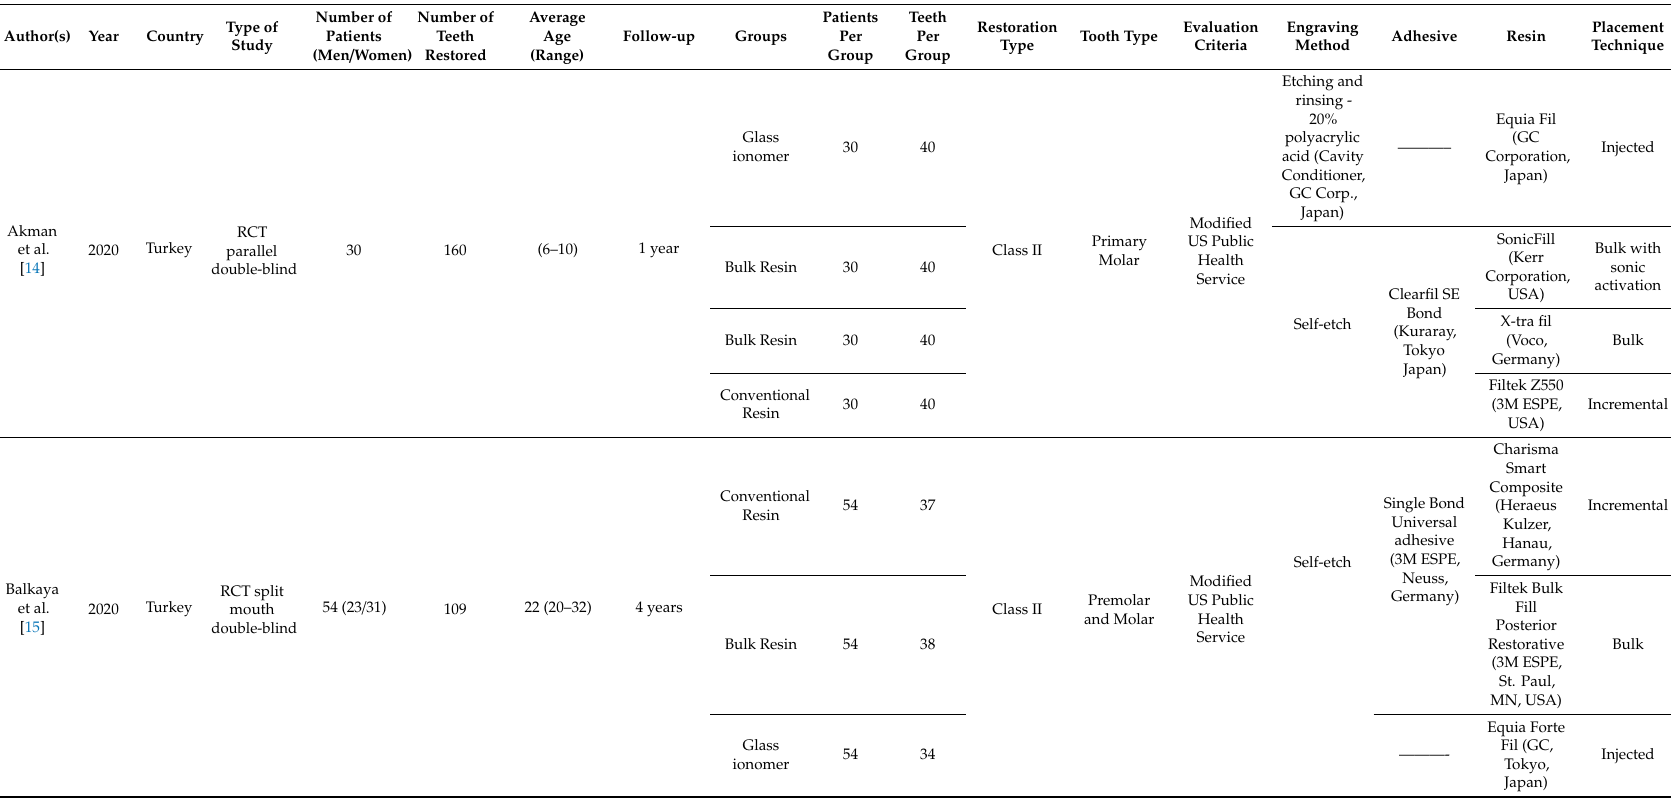
Table 2. Characteristics of included